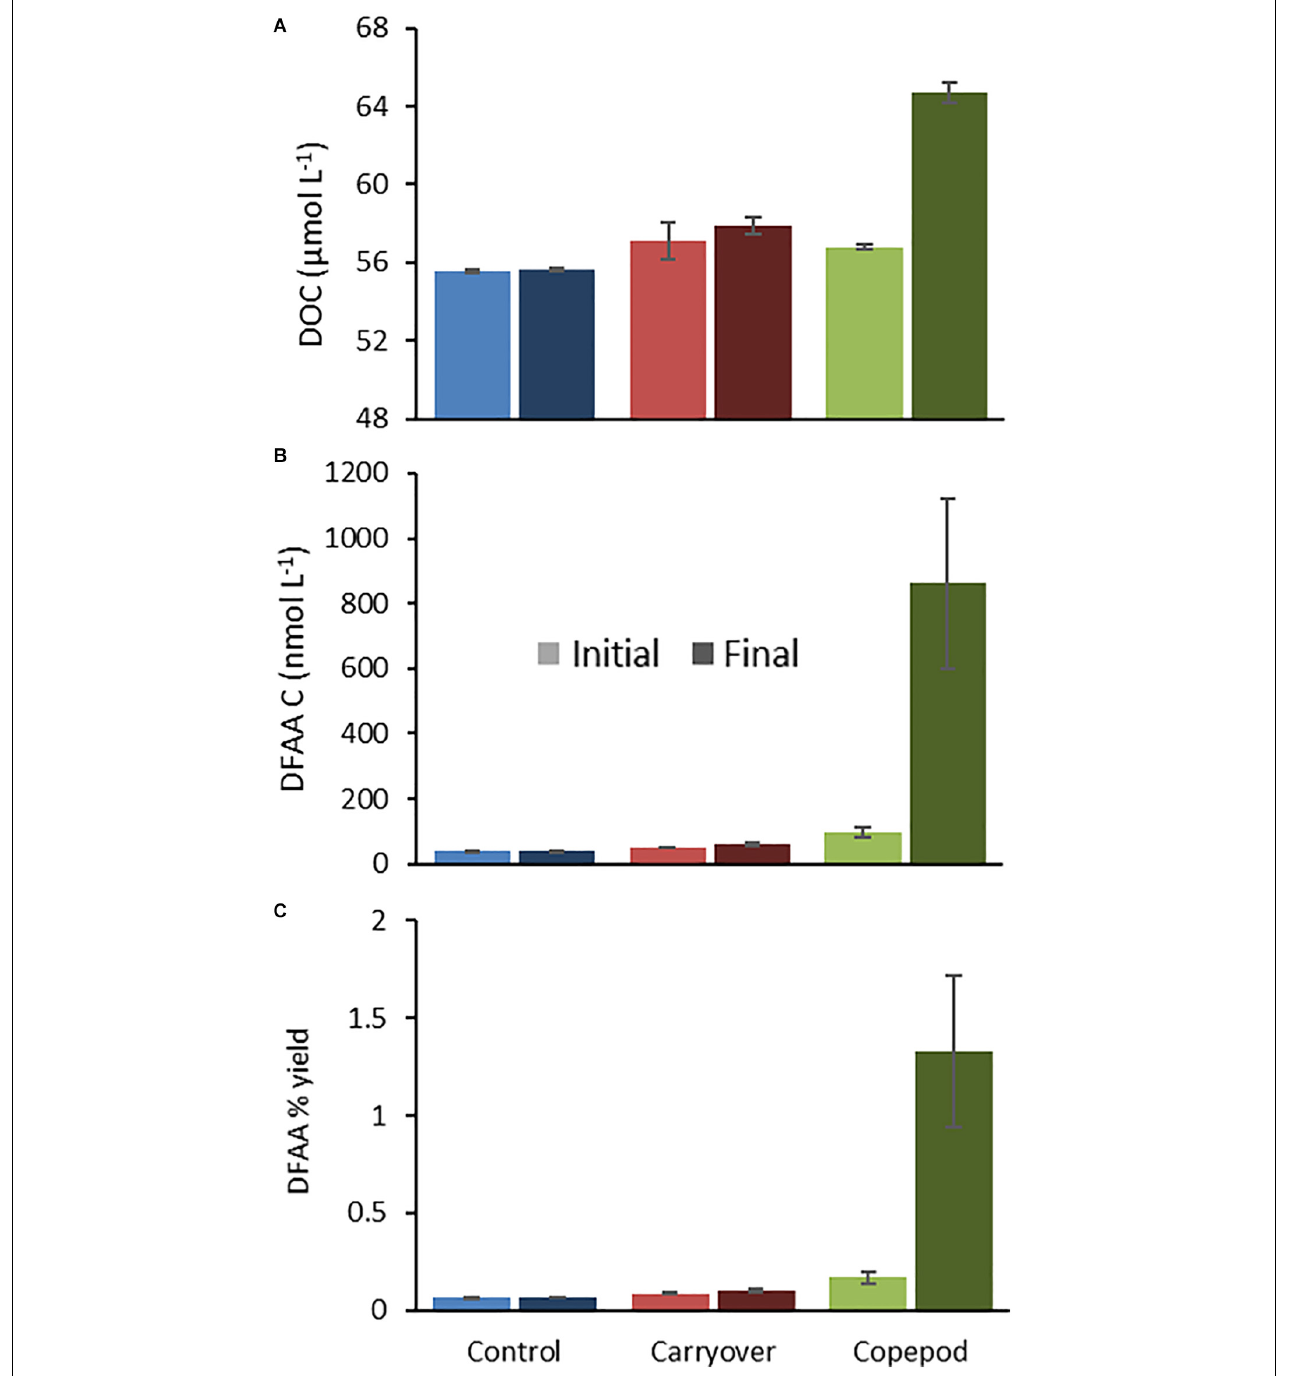
FIGURE 2 | Representative plots of DOC (A) and DFAA (B) concentration, as well as changes in diagenetic state (as indicated by DFAA yield) over the period of zooplankton excreta production (from 2016; experiment 1620-2) in duplicate bottles demonstrating a less altered diagenetic state of the copepod excreta (C) . Light bars represent T0 and dark bars represent